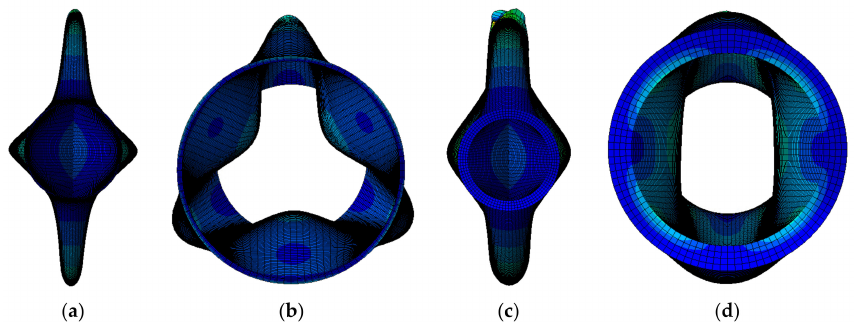
Figure 4. Buckling modes for modle 1~4 (Simple support) ( a ) Model 1; ( b ) Model 2; ( c ) Model 3; ( d ) Model 4.